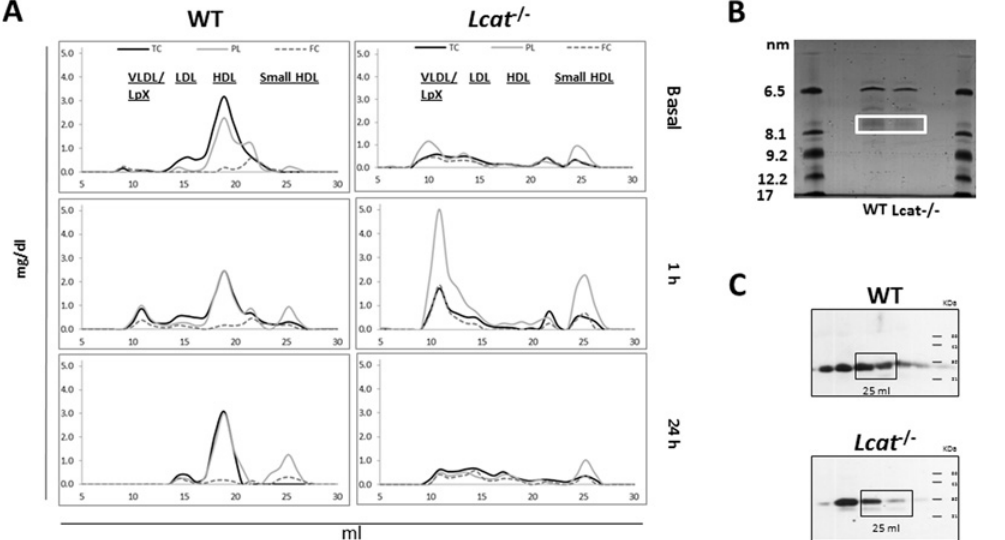
Fig 4. LpX metabolism in vivo . (A) Blood samples from Lcat -/- and WT mice were collected prior to ( “ basal ” ) and, at 1 and 24 hrs after LpX injection. Plasma samples from WT (n = 6) and Lcat -/- (n = 6) mice were pooled and lipoproteins were separated by FPLC. Phospholipid (PL), Total Cholesterol (TC), and Free Cholesterol (FC) were measured in collected fractions. Prior to LpX injection, TC, PL and FC were abundant in HDL in WT mice, whereas they were absent in Lcat -/- mice, which have only small amounts of lipids in VLDL/LpX and small HDL. One hour after injection in Lcat -/- mice, LpX PL and FC are clearly present in a large peak in the VLDL region, whereas in WT mice, the peak is reduced, consistent with our findings using fluorescent PE-tagged LpX (Fig 1B). One hour after LpX administration, a new peak in the HDL region (25 ml elution volume) appeared in WT mice; in Lcat -/- mice, this peak was observed prior to LpX administration and was increased at 1 hr post-injection. At this time, the PL and FC content of the Lcat -/- peak was increased compared to the Lcat -/- pre- injection peak, as well as to the WT peak. (B) Characterization of particles eluted at 25 ml using native gradient gel electrophoresis 1 hr post-injection. Native gradient gel electrophoresis confirmed that lipid-containing particles were present in the 25 ml fraction in the 7 – 8 nm size range. (C) SDS-PAGE (16% acrylamide gel) apoA-I immunoblot of small HDL particles (25 ml elution volume) generated by LpX at I hr. ApoA-I immunostaining confirmed the presence of apoA-I in these particles, which suggests that in the presence of apoA-I, LpX-derived PL, and to a lesser extent FC, increased the pool size of small HDL particles. These findings in vivo are consistent with the apoA-I and LCAT-dependent remodeling of LpX that we observed in vitro (Fig 1B – 1D). The peak is still visible 24 hours after injection in WT mice, while in Lcat -/- mice, it returns to basal levels (Fig 4A).